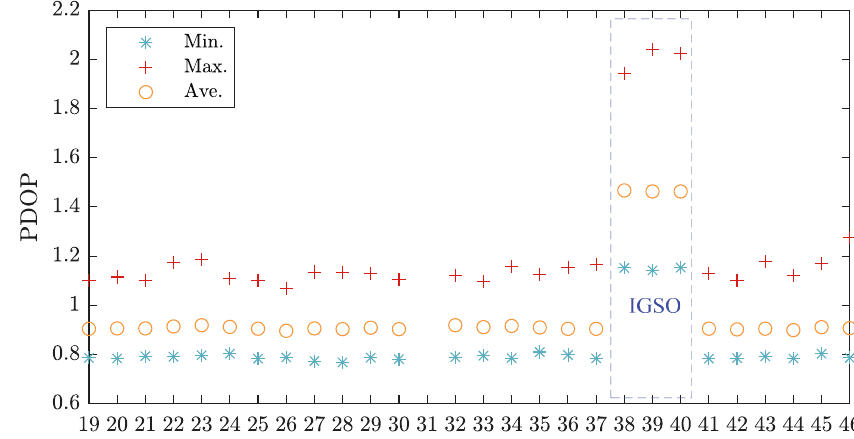
Figure 5: Statistical PDOPs of BDS satellites via ISLs.